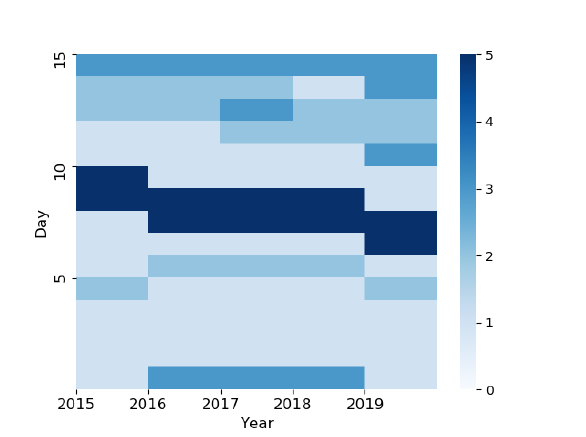
Figure 8: Clustering output for NO 2 for first 15 days in Q 3 over 2015 to 2019.